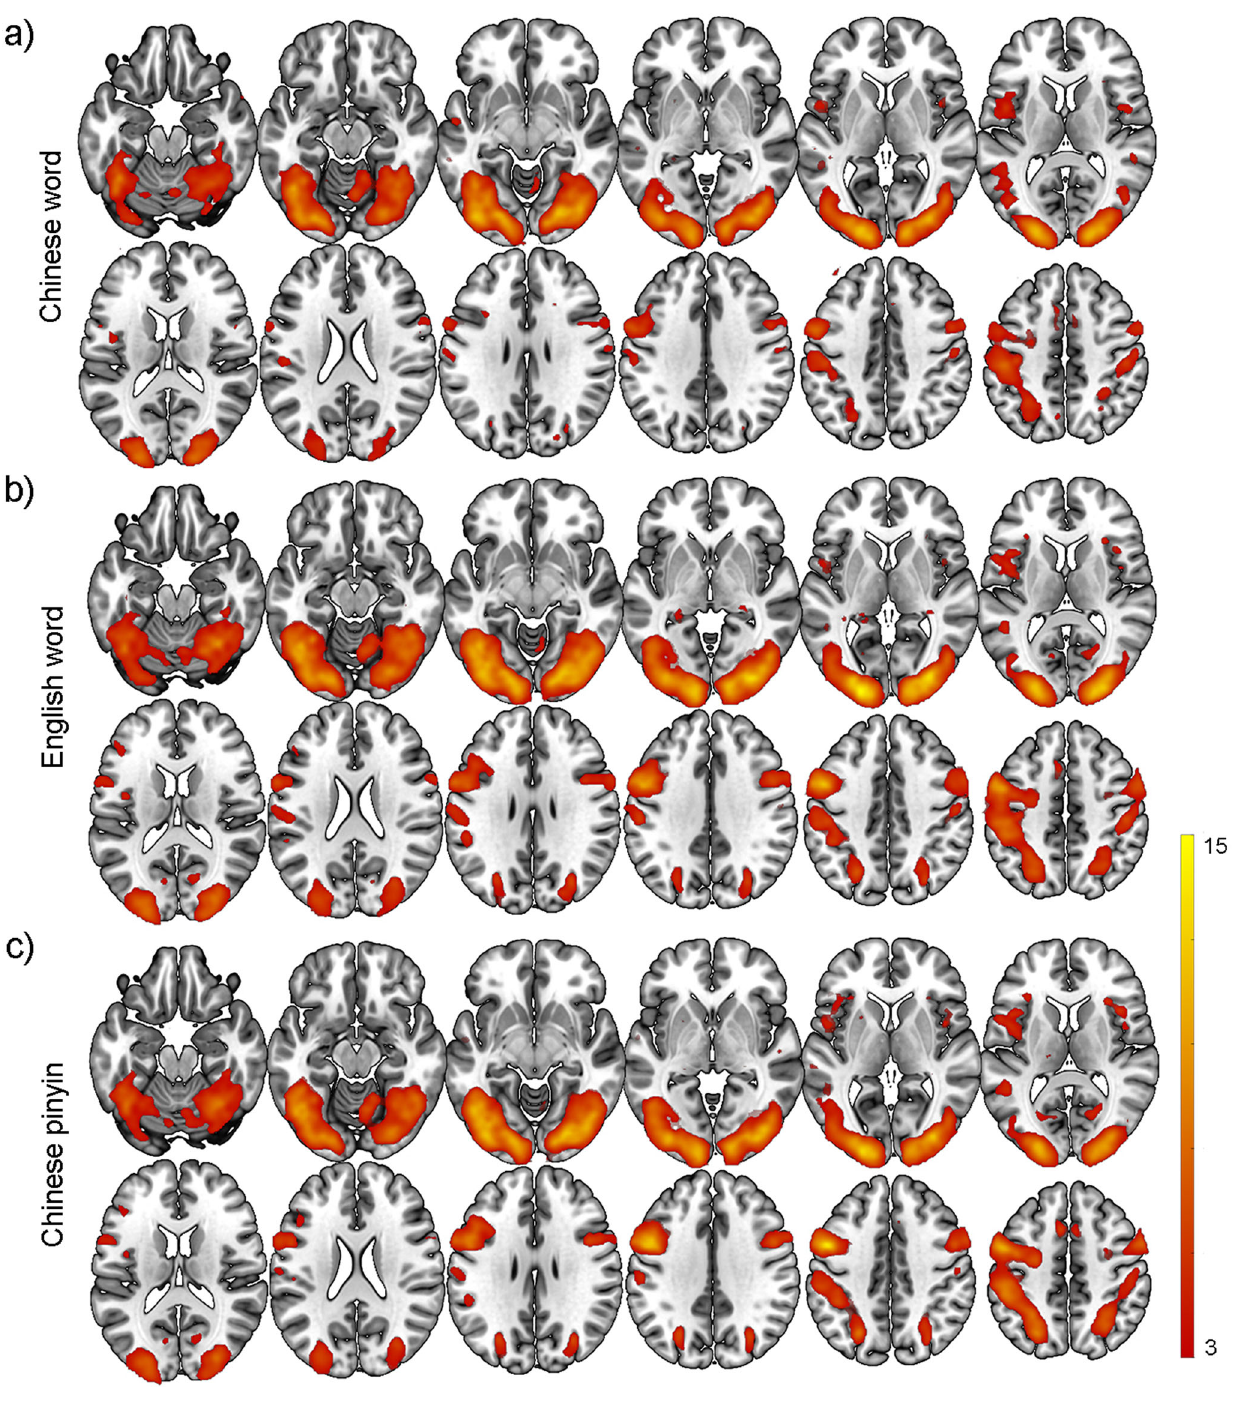
Fig. 2 Activation analysis for Chinese words, English words, and Chinese pinyin reading tasks. Second-level general linear models (GLMs) were performed separately to obtain activation maps for the recognition of a Chinese words, b English words, and c Chinese pinyin. Brighter colors indicate higher t values. (Voxel-wise p < 0.05, FDR corrected p < 0.05, and cluster size